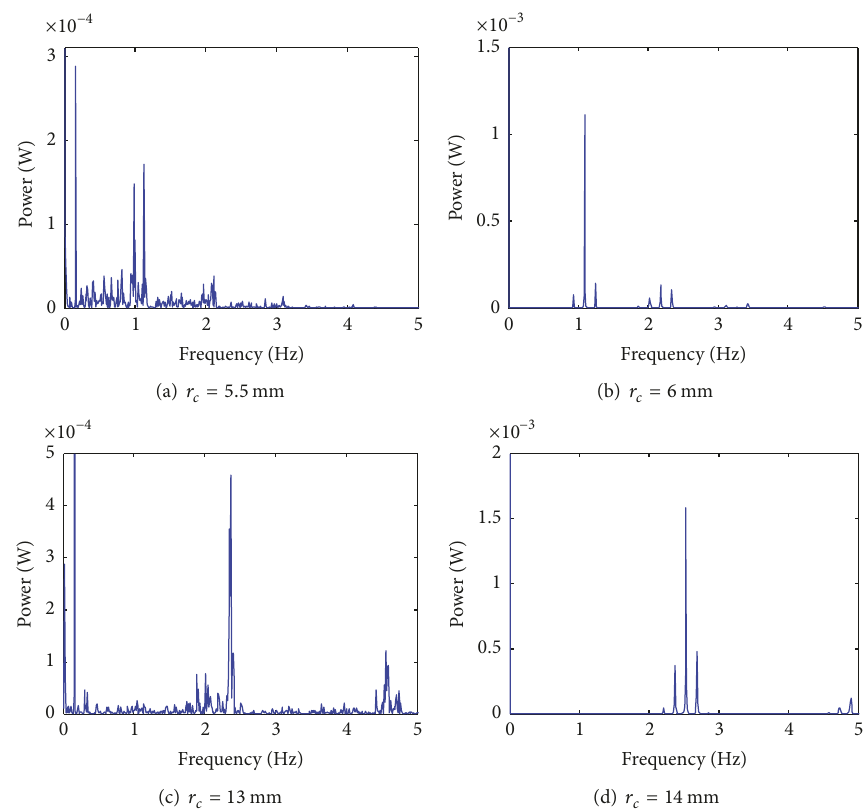
Figure 12: Power spectrum of vibration response of rigid cog for different theoretical radius.